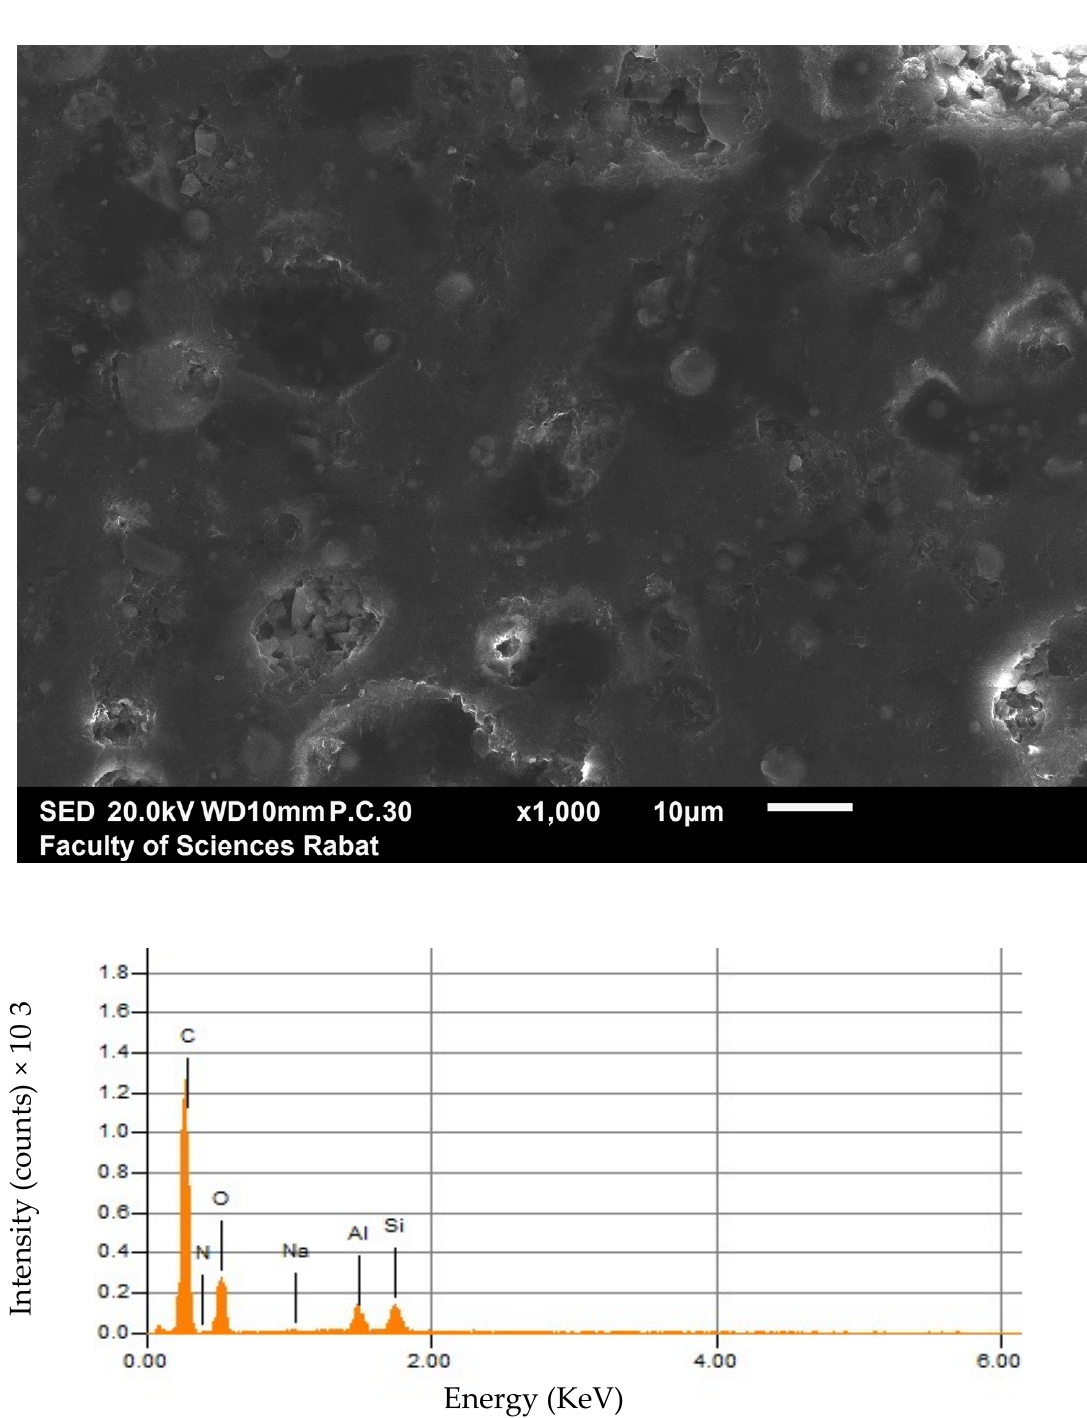
Figure 8. Representative SEM image and EDX elemental analysis surface of composite material after erosion test.